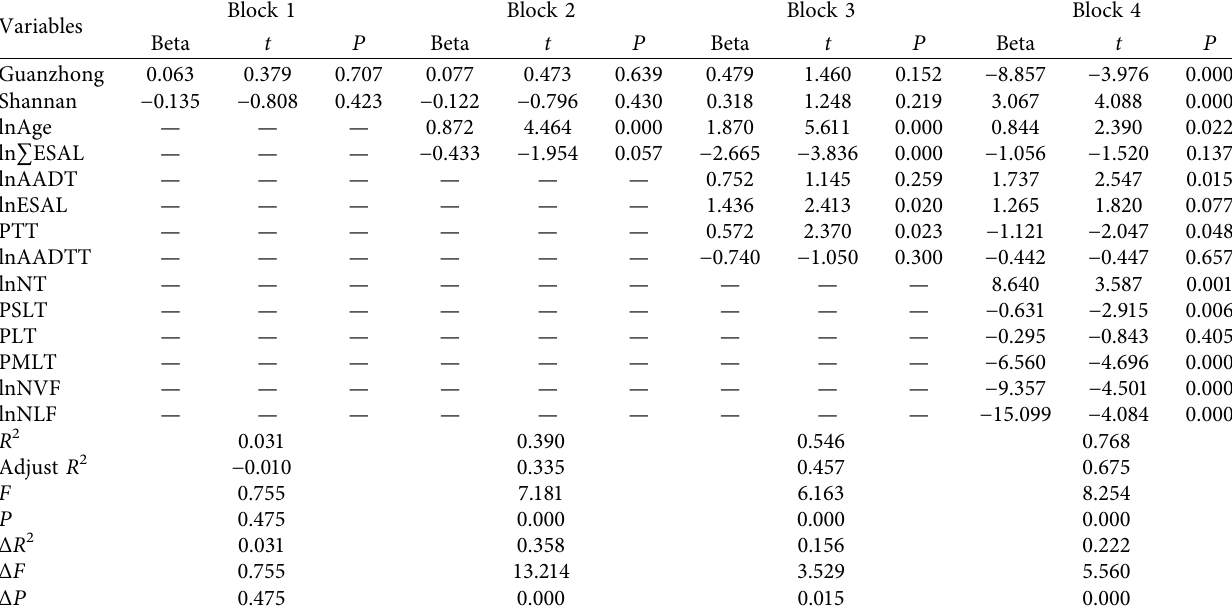
Table 4: Te results of hierarchical regression